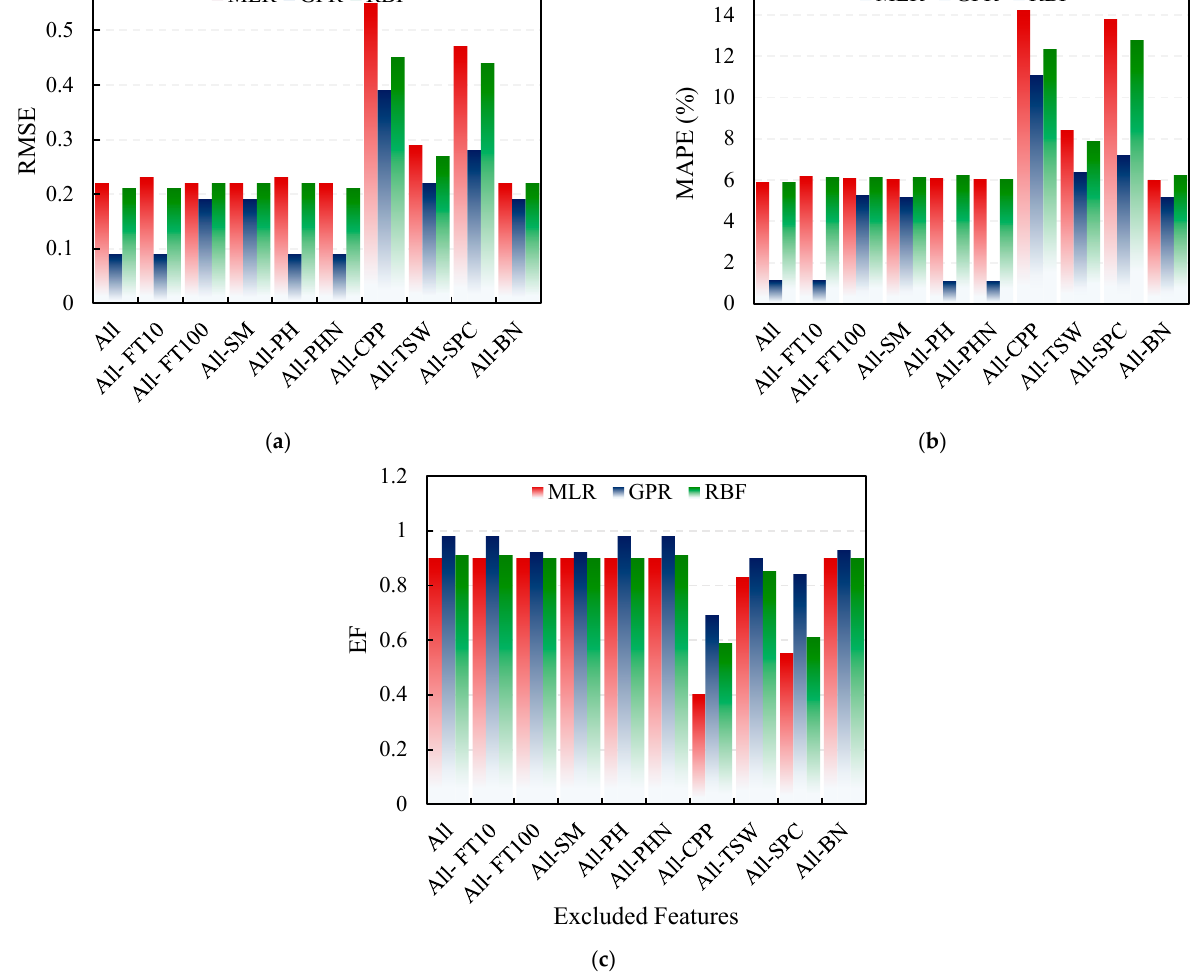
Figure 8. Sensitivity analysis results for MLR, GPR, and RBF models to assess the SSY based on the (a) RMSE, (b) MAPE and (c) EF criteria.